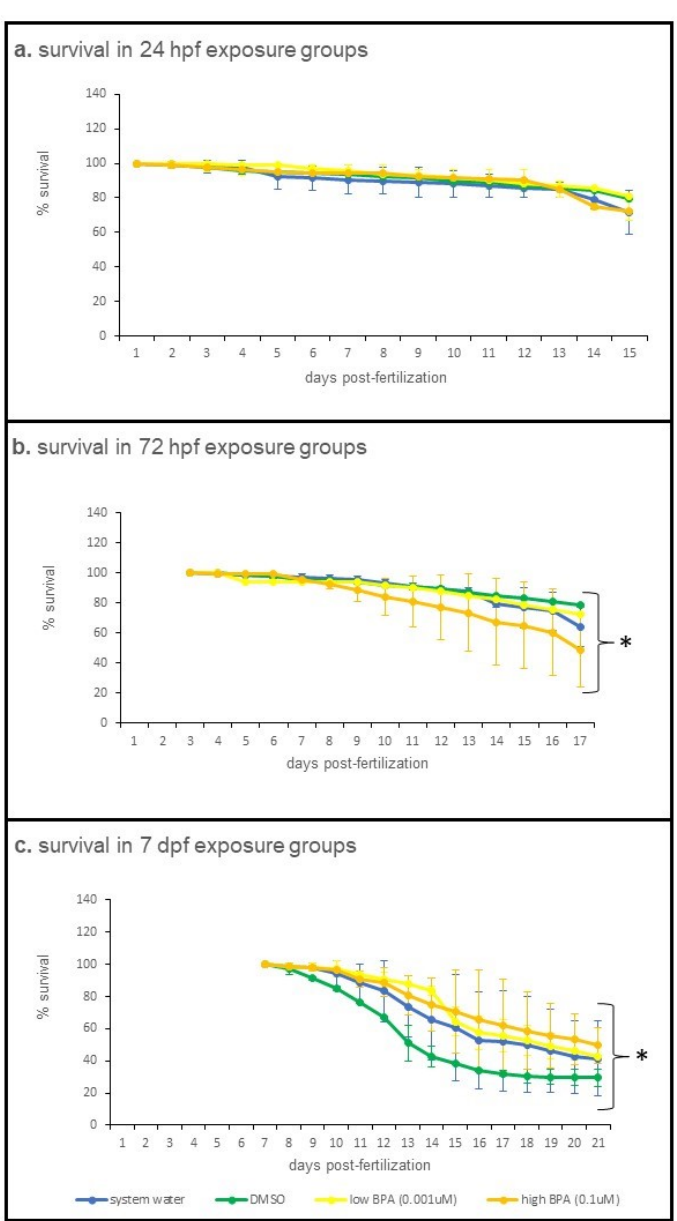
Figure 1. Survival trends across all exposure ages and recovery sampling points. Survival was analyzed using a general linearized model, with treatment as the fixed factor and day as the co-variate. Values are reported as mean percent daily survival ± SD for each treatment group. ( a ) Overall daily survival of larvae exposed at 24 hpf was unaffected by treatment ( p = 0.238). For 24 hpf exposures, initial populations were as follows: system water = 341; DMSO = 250; low BPA = 355; high BPA = 250. ( b ) Overall daily survival of larvae exposed at 72 hpf was significantly impacted by treatment ( p < 0.001). For 72 hpf exposures, initial populations were system water = 293; DMSO = 250; low BPA = 298; high BPA = 250. ( c ) Overall daily survival of larvae exposed at 7 dpf was significantly impacted by treatment ( p = 0.005). For the 7 dpf exposure groups, survival between treatment groups was assessed at 1 week and 2 week postexposure using one-way ANOVA, followed by a Tukey post hoc test; survival at these points was not significantly different: p = 0.191 at 1 week (14 dpf), and p = 0.811 at 2 weeks (21 dpf). For 7 dpf exposures, initial populations were system water = 231; DMSO = 221; low BPA = 293; high BPA = 226. Asterisks denote significant differences.